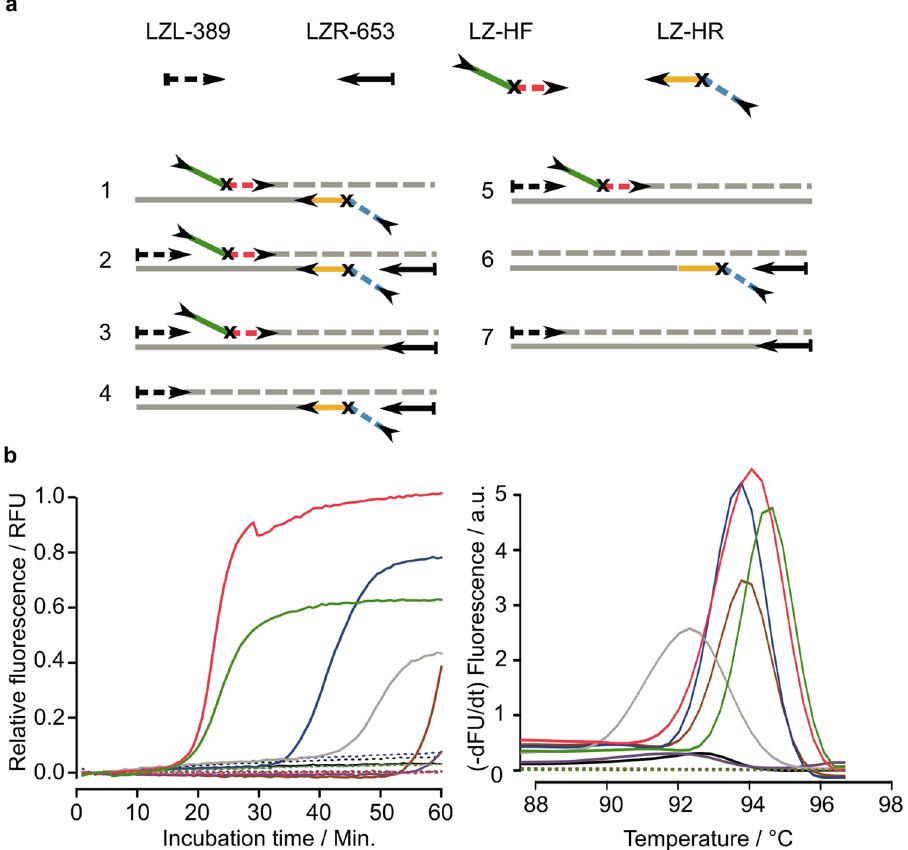
Figure 4. Analysis of the reaction kinetics with respect to different hinge-primer combinations using dSpacer as blocking-site. ( a ) Overview of primer combinations for symmetric reaction (1–2) and asymmetric reaction (3–7) ( b ) Normalised real-time amplification curves for each combination. ( c ) Melting-curve analysis. Red: combination 1, green: combination 2, blue: combination 4, grey: combination 3, brown: combination 6, violet: combination 5 and black: combination 7. Solid lines represent reactions with 5 ng genomic DNA ( E.coli ) and dashed lines are non-template controls.